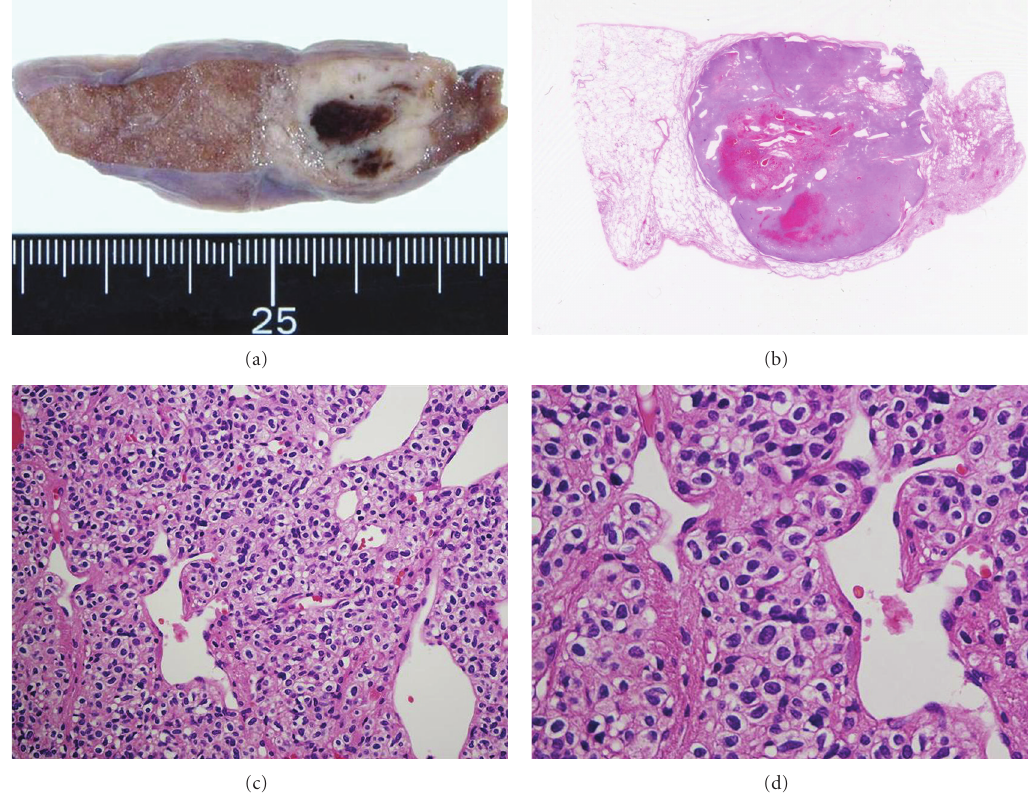
Figure 2: (a, b) The excised tumor, measuring 2 . 0 × 2 . 0cm, appeared as a well-circumscribed nodular lesion with a whitish color and focal central hemorrhage. (c, d) Histological findings for the removed tumor revealed uniform small round to oval cells with a centrally located nucleolus, a clear cytoplasm, and clear cell borders. Branching vessels with a hemangiopericytomatous pattern (HPC-pattern) were also